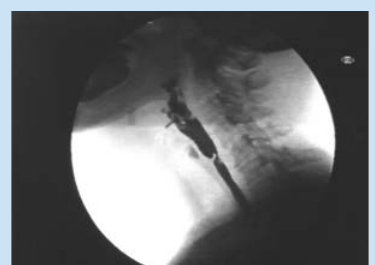
Fig. 4a. Oesophageal web shown in lateral erect position.